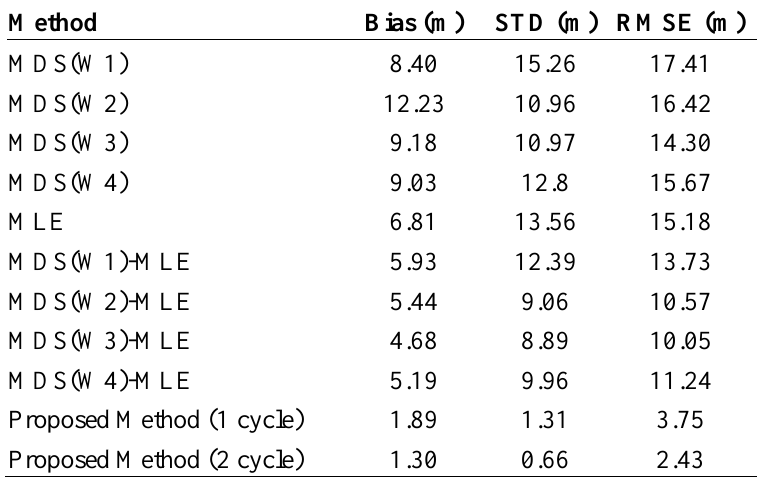
Table 2. Performance statistics of the proposed algorithm and different methods using previous proposed weighting schemes * W1 [20], W2 [40], W3 [41] and W4 [42].